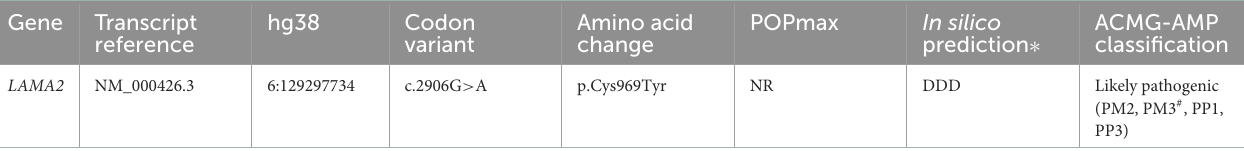
TABLE 1 Genetic summary table for novel variant. Gene Transcript reference